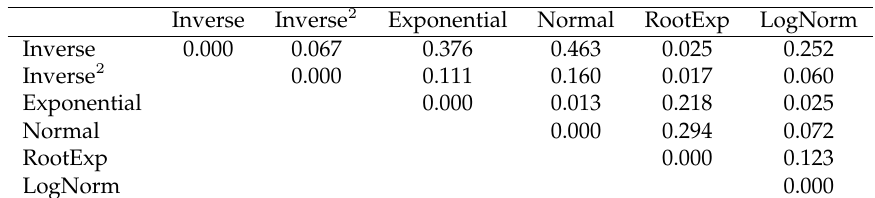
Figure 4: Distance of the location of highest probability ( l t ) from the field-based time ge- ography model to the linear interpolated path (the bee-line) for each of the three scenarios. Example P i,t surfaces show time-slices of the field-based space-time prism associated with specific time points during the segment.